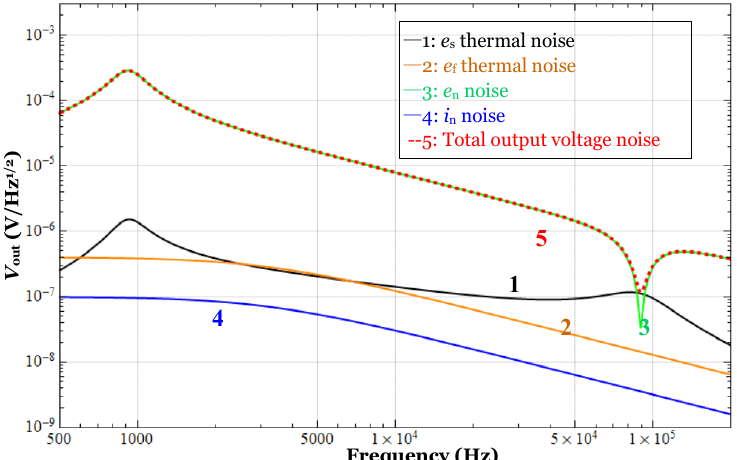
Figure 4. The noise curve estimation of the front-end circuit of the capacitive sensor with a coaxial cable.